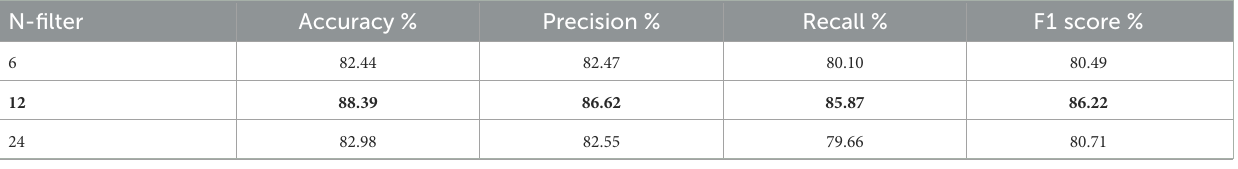
TABLE 3 Table of average performance results generated by adjusting the parametric Mel filter number model. N-filter